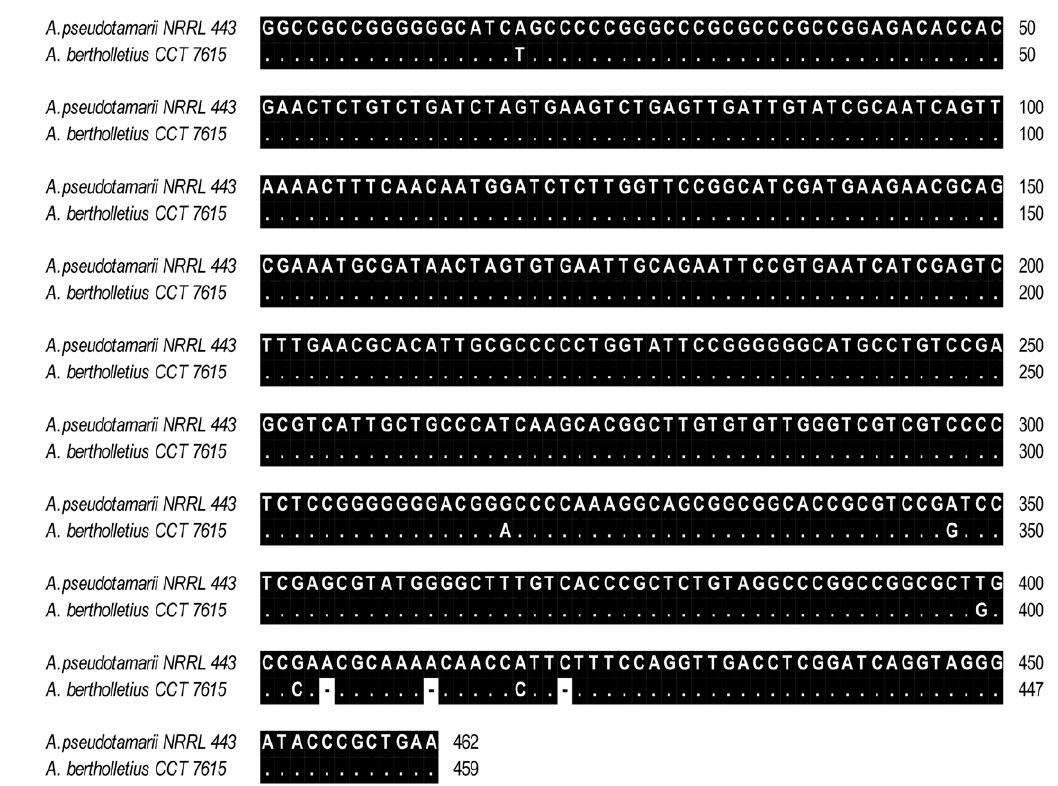
Figure 3. Nucleotide sequence alignment of a 459-bp fragment of the ITS-5.8S-ITS region of Aspergillusbertholletius (accession no. JX 198673, present study) and A.pseudotamarii (AF004931).